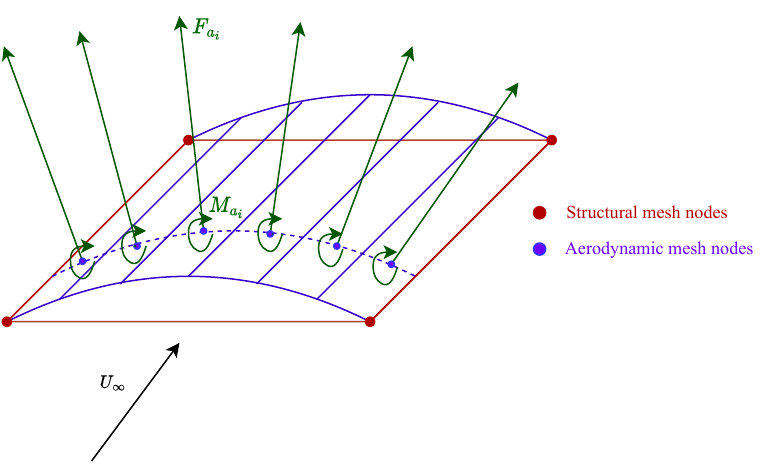
Figure 7. Structural and aerodynamic meshes with largely different spanwise resolutions [26]. While not illustrated in this schematic, the quadrilateral defined by the structural mesh nodes is not necessarily planar but skewed in the general